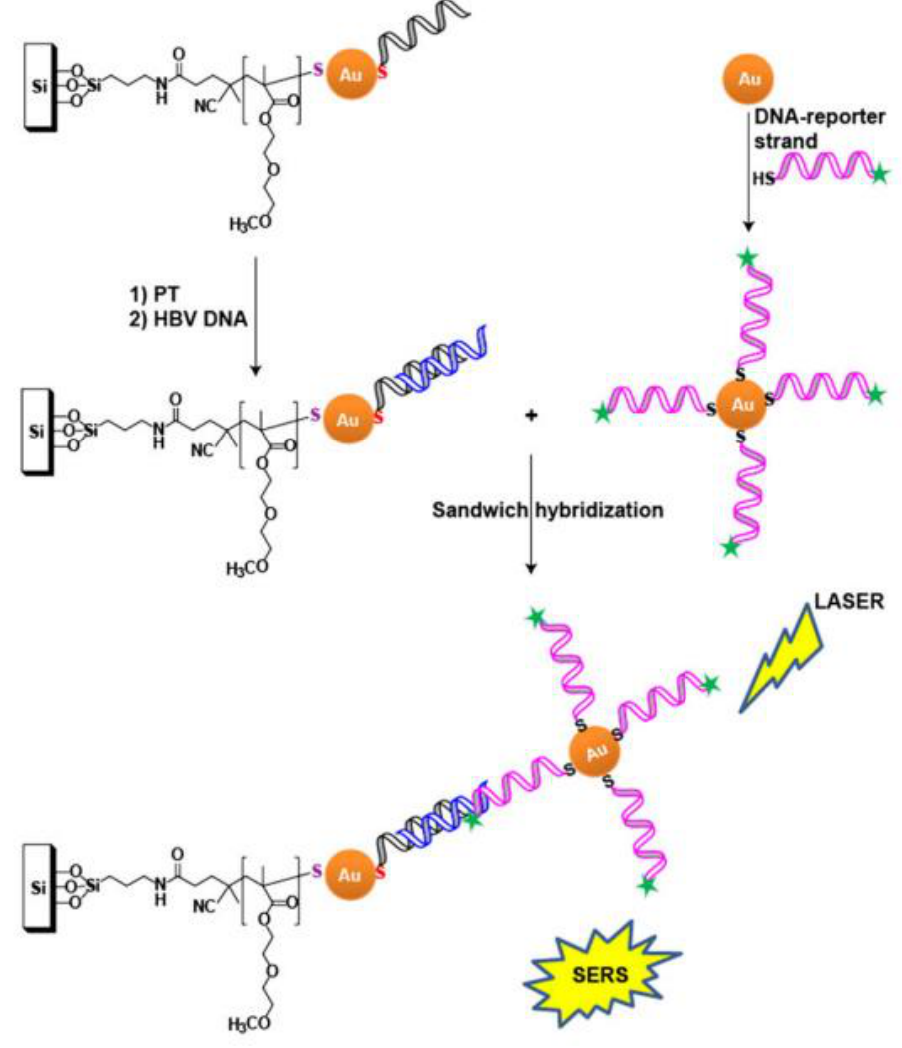
Figure 3. ASO-based identification of viral genome on solid substrates. Ternary complex formation is necessary for the generation of a SERS signal. Viral genome is shown in blue, and primary and secondary ASO are shown in black and magenta, respectively. Reproduced with permission from [55]. Copyright Wiley, 2017.